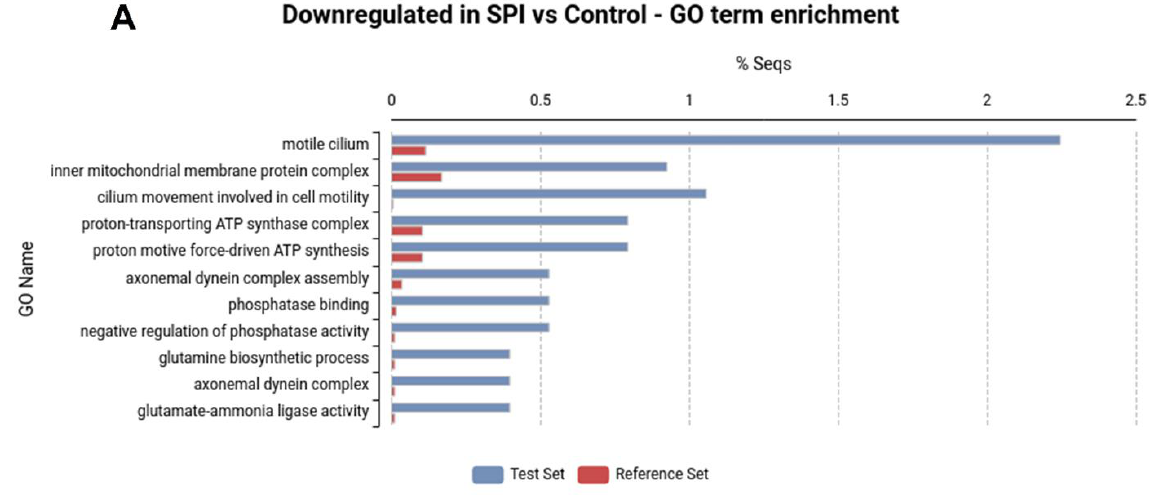
Figure 2. Enrichment analysis showing percentage of sequences associated with over-represented GO terms out of the genes that were ( A ) downregulated, ( B ) upregulated in the digestive system of H. armigera by the presence of SPIs in the artificial diet, and ( C ) downregulated in the digestive systems of H. armigera progeny that were exposed to SPIs in comparison to reference set (all genes expressed).